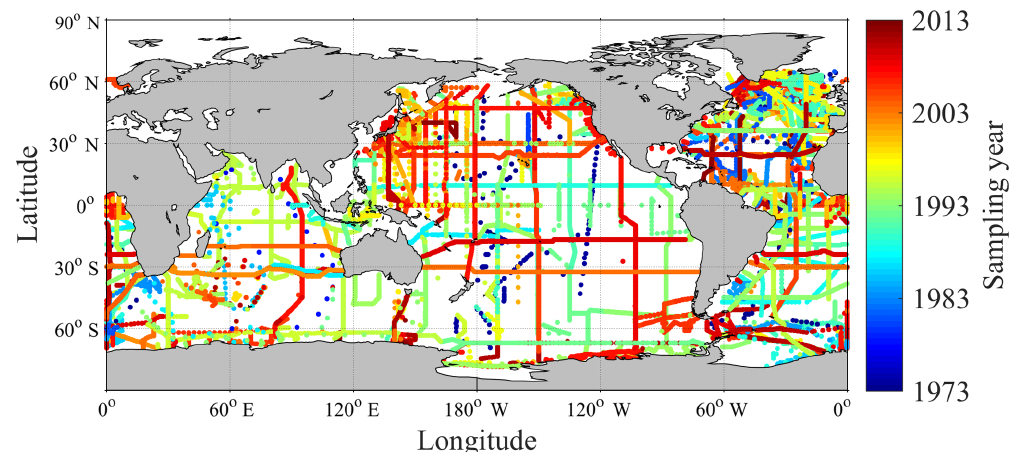
Figure 3. Spatial and temporal distribution of GLODAPv2 sampling stations (with Arctic and Mediterranean Sea data removed).